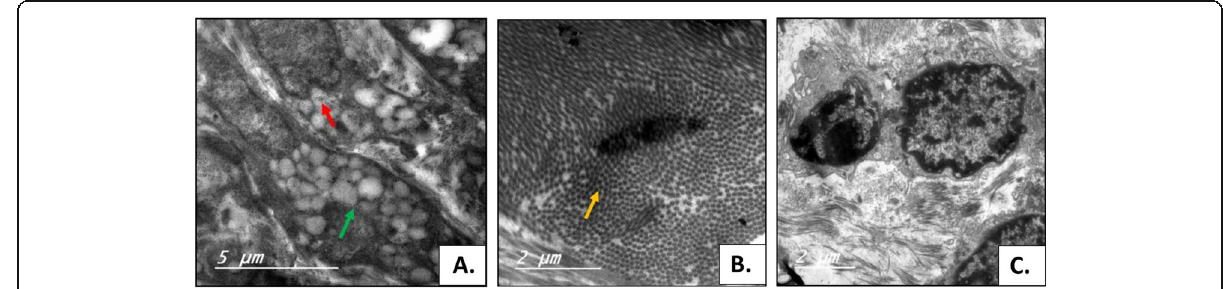
Fig. 5 A Ultrastructure image showing intracellular lipid and mucoid vacuoles (denoted with green arrow) with nuclear invagination (denoted with red arrow). B Ultrastructure photograph showing increased number of collagen fibers. C Ultrastructure image showing nuclear invagination and two nucleoli